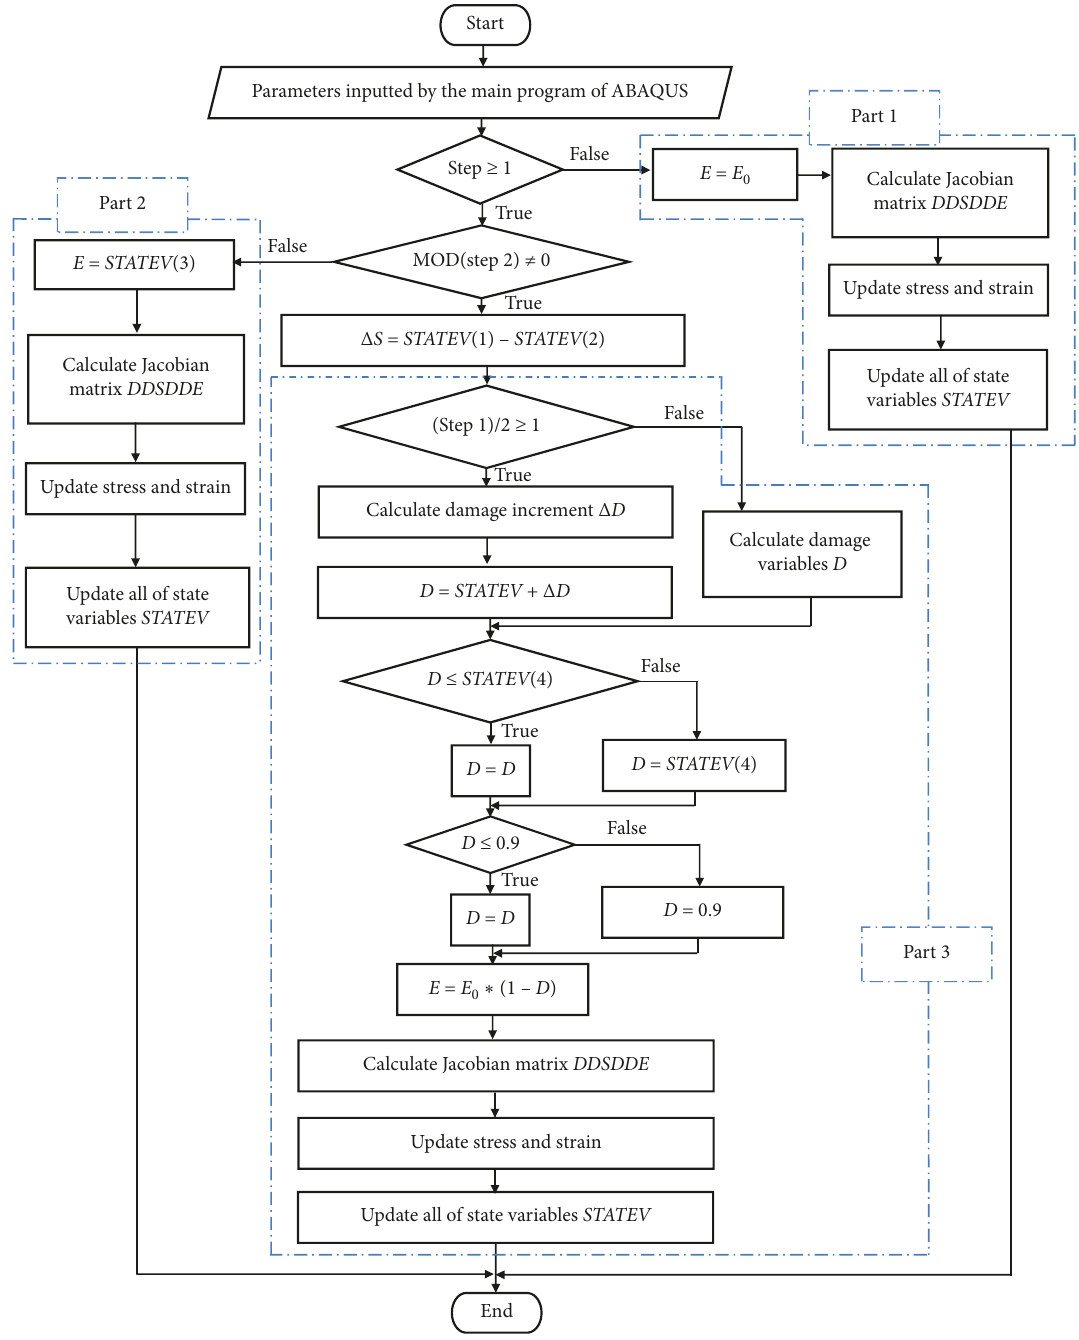
Figure 9: The algorithm flow diagram of